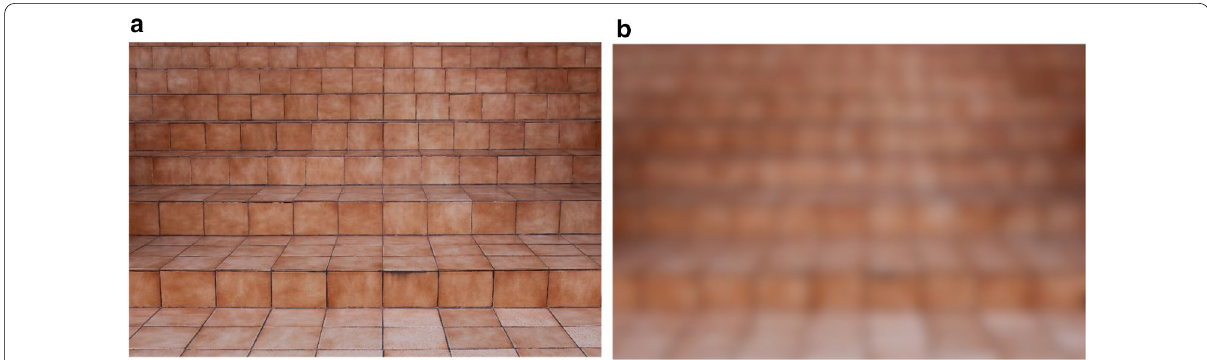
Fig. 2 Steps viewed with normal vision ( a ) as compared to simulated degraded acuity and contrast sensitivity ( b ) demonstrating loss of detail and texture gradient of steps